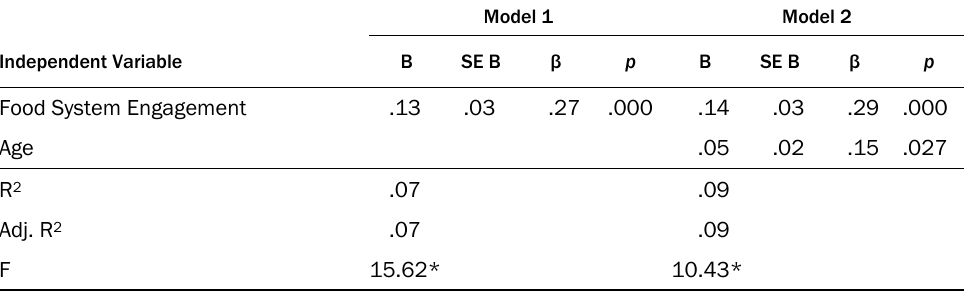
Table A3. Dependent Variable: Psychological Well-Being Behavioral